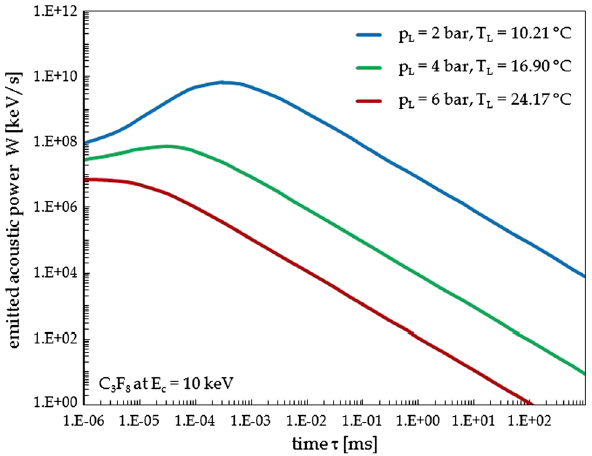
Fig. 5 Distributions of W vs. time using p L and SH as parameters